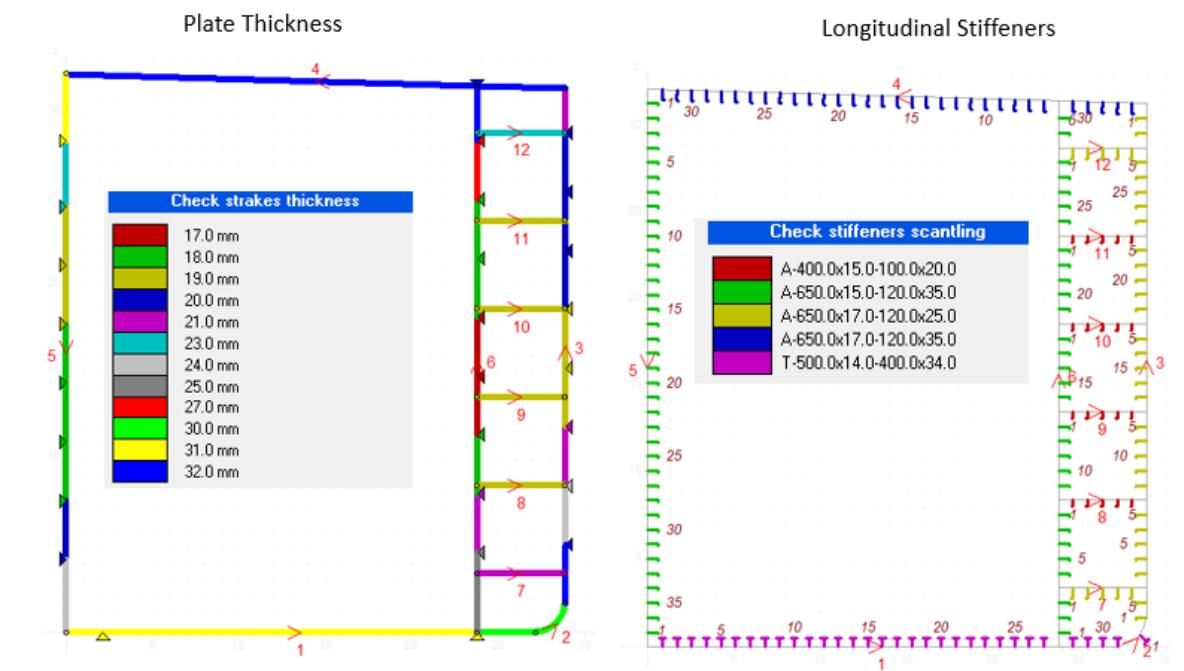
Figure 5. Final distribution of plate thickness and the longitudinal stiffeners.